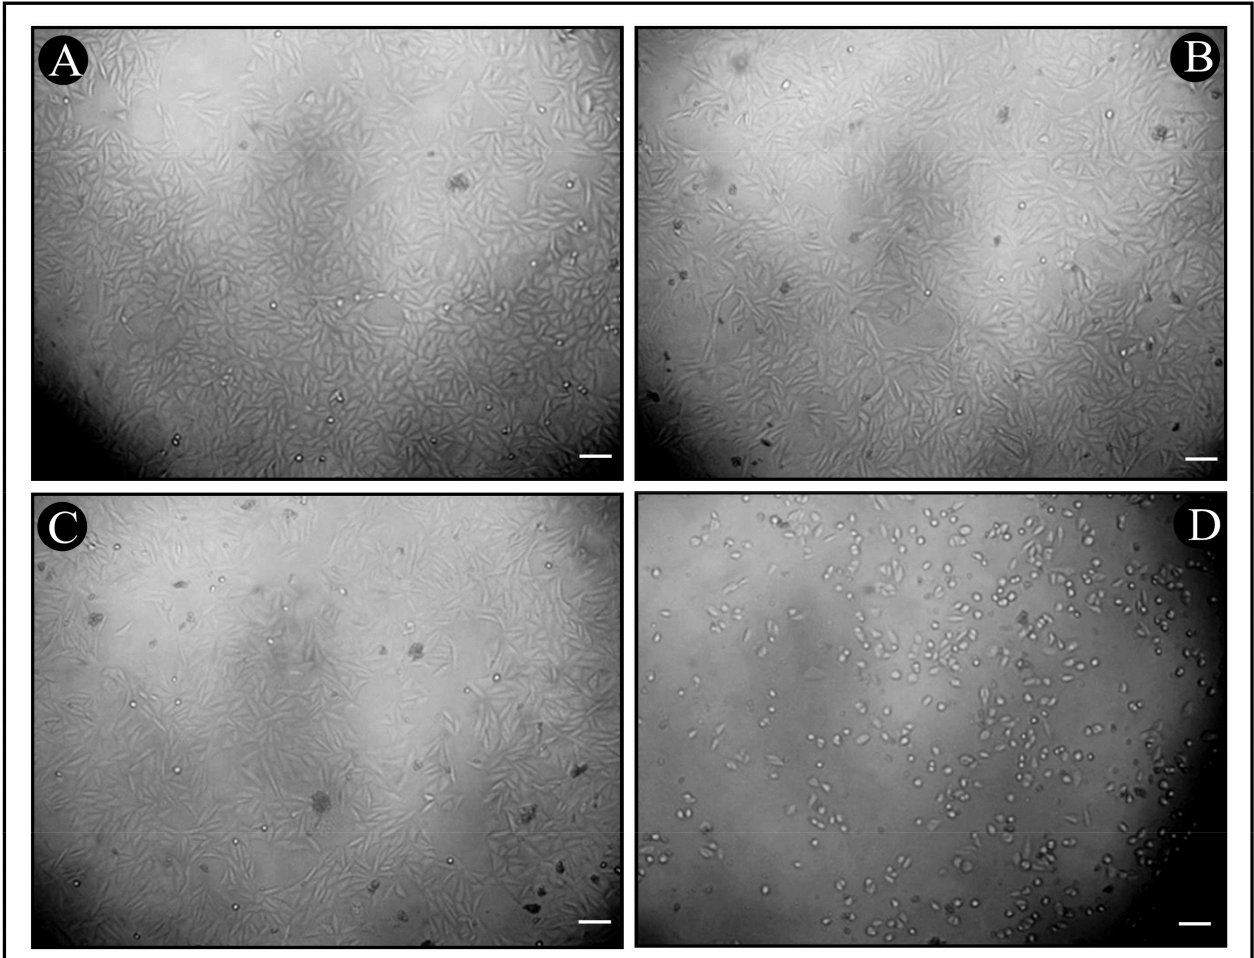
Figure 6. Morphological analysis of HepG2 cells under inverted microscope after treatment with different concentrations of Bac10307-AgNPs with morphological changes. ( A ) Untreated, ( B ) 4 µ g/mL, ( C ) 64 µ g/mL, ( D ) 256 µ g/mL (magnification 20 × , scale bar 50 µ